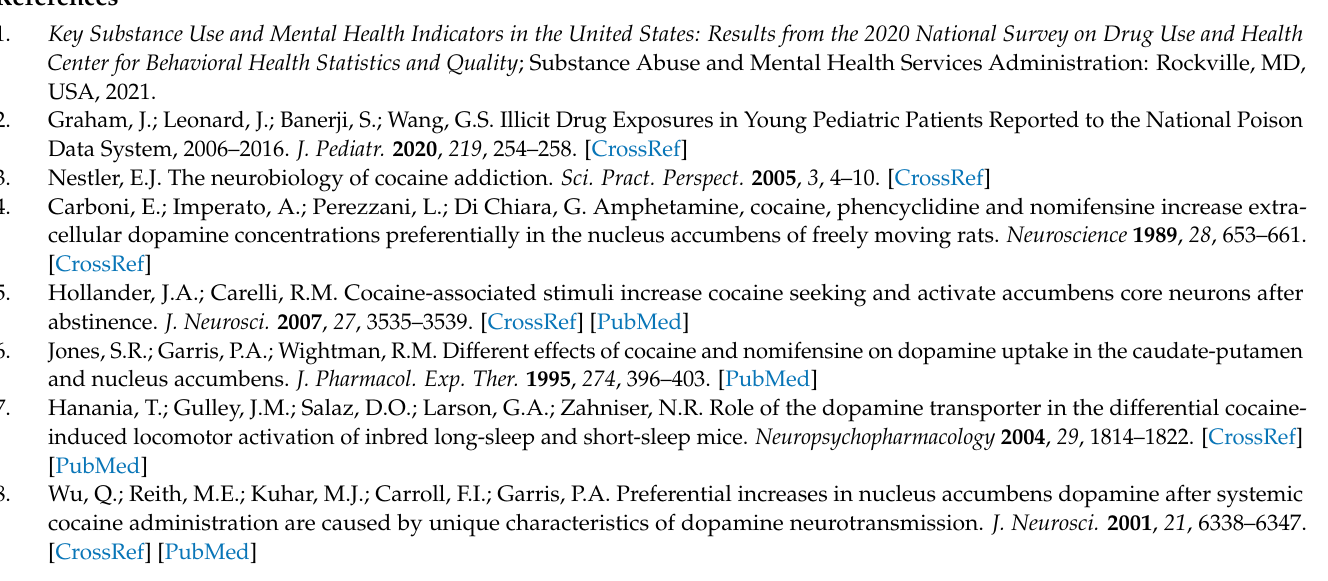
Figure S2: Impedance of sensors as fabricated, after fuzzy Au deposition, and after aptamer/MCH immobilization; Figure S3: Impedance of sensors before and after PSB coating; Figure S4: SWV waveform for calibrations comparison before (A) and after (B) PSB coatings; Figure S5: In vitro PBS injection experiment in 0.6% agarose; Figure S6: In vivo electrophysiology recording spike stream data; Table S1: Summary and comparison of previous works with PSB catechol zwitterionic polymer